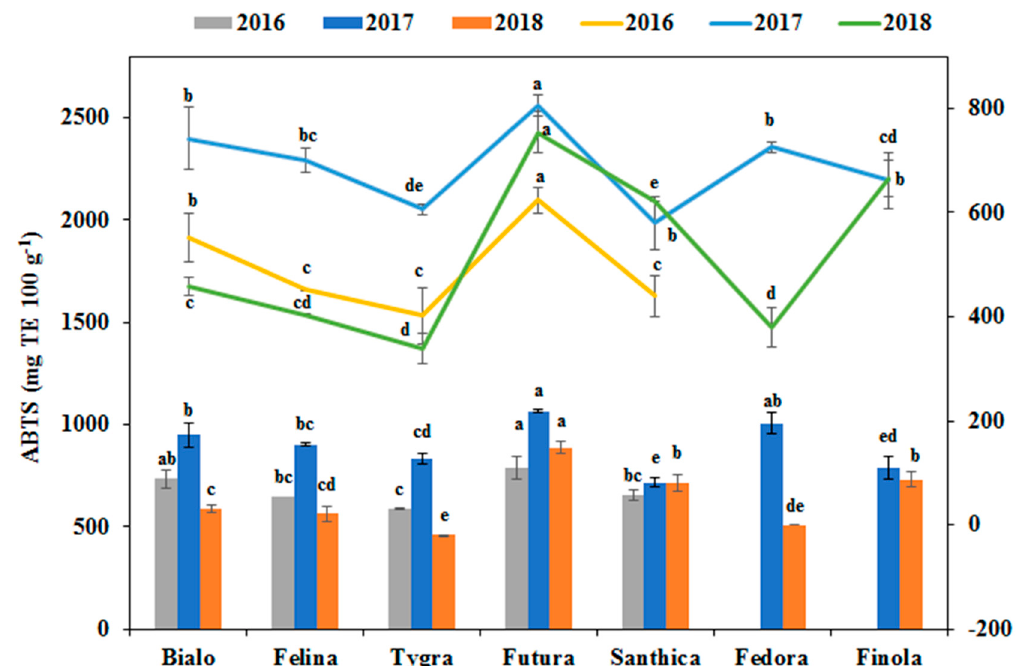
Figure 5. Antioxidant activity of extracts of hemp seeds from the seven industrial hemp cultivars cultivated in this study and for three growing seasons (2016, 2017, and 2018) as measured by 2,2 ′ -azino-bis (3-ethylbenzthiazoline sulfonate) (ABTS) and ferric-reducing antioxidant power (FRAP) assays. For each year, means within the column in the same color or in the same line followed by the same letter are not significantly different ( p > 0.05).